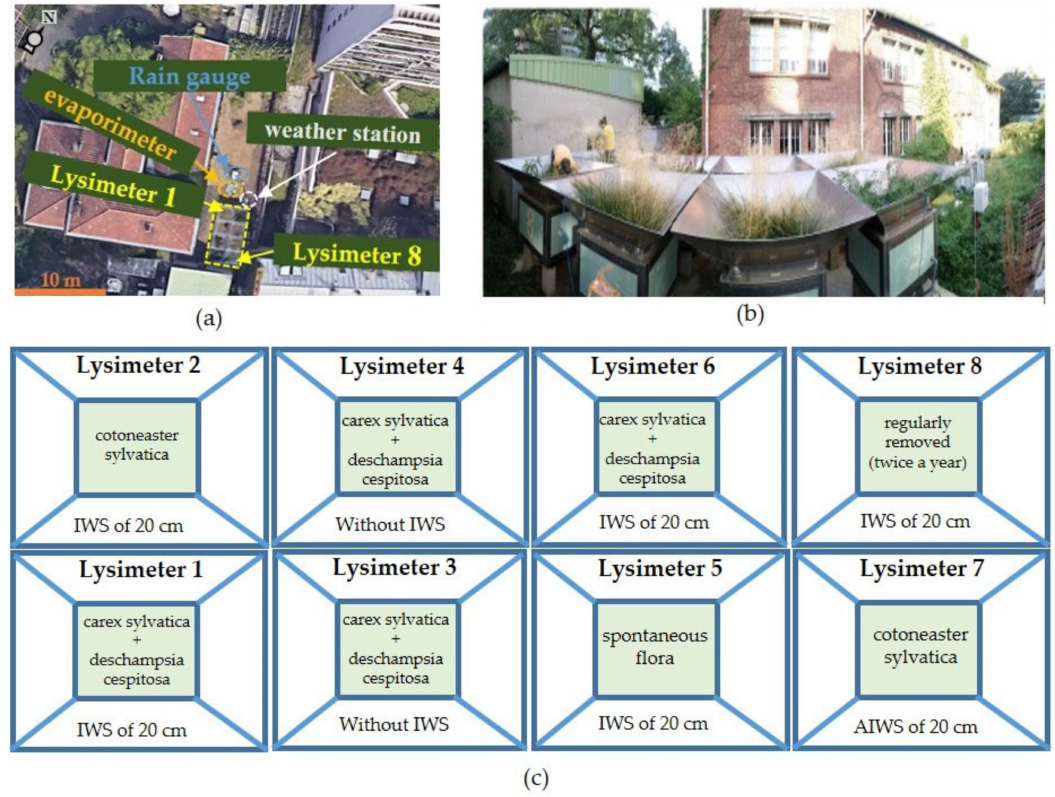
Figure 2. A top and panoramic views of the site in figures ( a ) (Source: google earth) and ( b ), respectively. The figure ( c ) illustrates the positions and the scientific names of vegetation in each lysimeter.